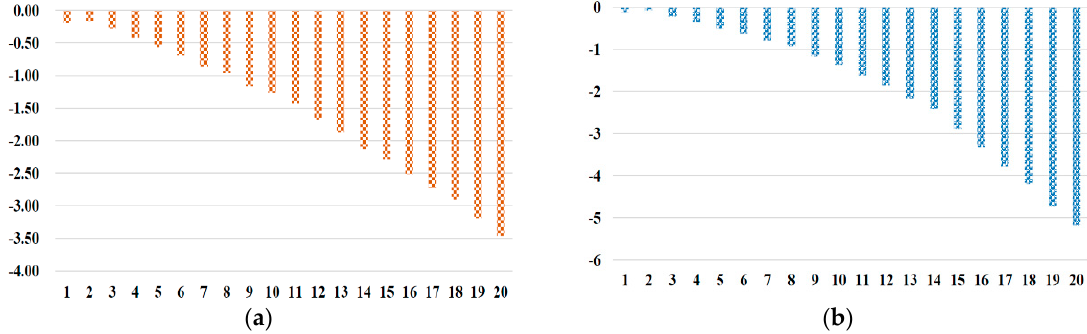
Figure 4. Impacts of the trading mechanism under scenario T (%), ( a ) carbon emissions ( b ) GDP.